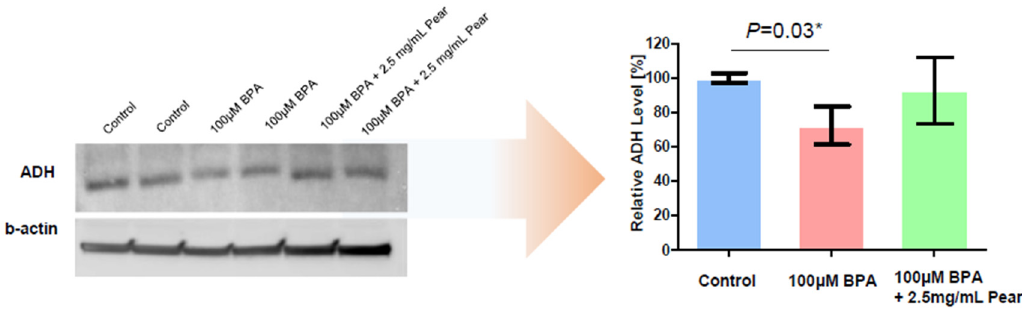
Figure 5. Not arbutin but Korean pears increased normalized IC 50 values of BPA: *( P < 0.05), compared to the control (BPA only treated); N = 3 for each group.